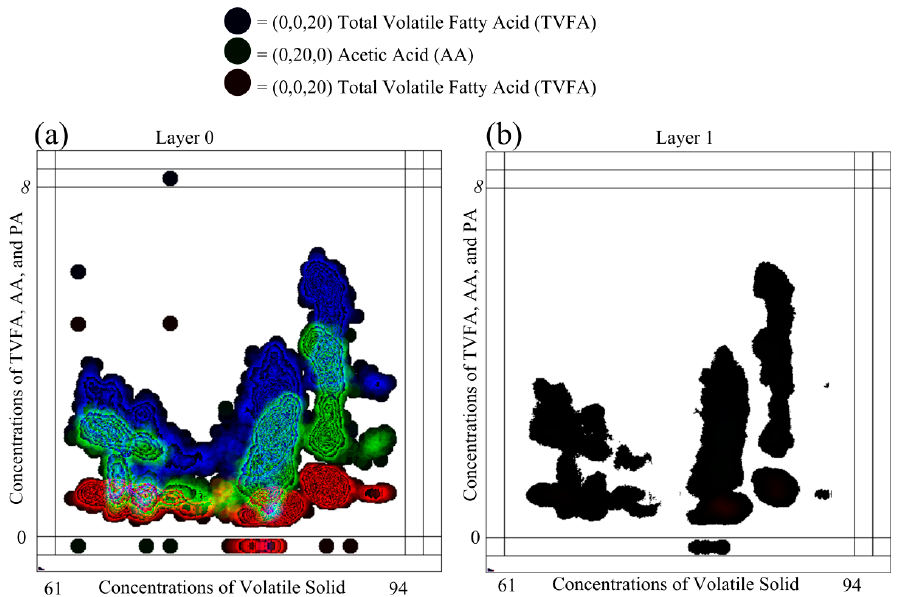
Figure 8. The MLMV-GKU representation of the same data shown in Figure 6 with a different color scheme. ( a ) Layer 0 of the MLMV-GKU; ( b ) Layer 1 of the MLMV-GKU. As in Figure 6, the effective bitmap width and height are 400 and 400 pixels for representing the data of three dependent variables (concentrations of total volatile fatty acids (TVFA), acetic acid (AA) and propionic acid (PA)) against the concentration of volatile solids where each dependent variable consists of 2885 data points. All of the data are normalized using the max ‐ min normalization method and used 400, 250 and 250 pixels as new_max A for TVFA, AA and PA, respectively. The initial color of each variable is (0, 0, 20), (0, 20, 0) and (20, 0, 0). A circle of a radius of 10 pixels is used as the DPS. The MLMV ‐ GKU shows visual density clusters only in high overlapping areas. When there is low overlapping, it is not possible to distinguish points in relation to variables, such as P A , P B and Layer 0. Plot (a) of Figure 9 shows the compression of the conventional scattered plot for one independent and three dependent variables and plot (b) of Figure 9 the MLMV ‐ GKU of two layers for the same variables. The plots represent 21,951 data points, where the effective bitmap width and height are 400 and 625 pixels, respectively. Plots represent data in relation to three dependent variables (TVFA, AA and PA) against the concentration of volatile solids (VS). All of the data are normalized using the max ‐ min normalization method and used 625, 550 and 225 pixels as new_max A for TVFA, AA and PA, respectively. In the MLMV ‐ GKU, the initial color of each variable is (255, 255, 10), (255, 10, 255) and (10, 255, 255). A circle of a radius of 10 pixels is used as the DPS. The MLMV ‐ GKU shows density clusters of each variable by means of automatically ‐ generated contour lines, which can be easily identified by the naked eye. This is a special feature of the GKU, which is not possible with a scatter plot.